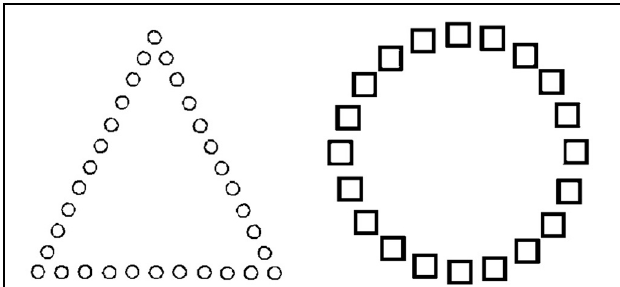
FIGURE 2 | Global-local task of cognitive control. For the item on the left, the circle is the target, presented on a local dimension. For the item on the right, the target circle is presented on a global dimension [reproduced with permission from Baumann and Kuhl (2005)]. Participants in a positive mood demonstrated increased cognitive control by responding to non-dominant local features (i.e., detecting the target circles that made up the